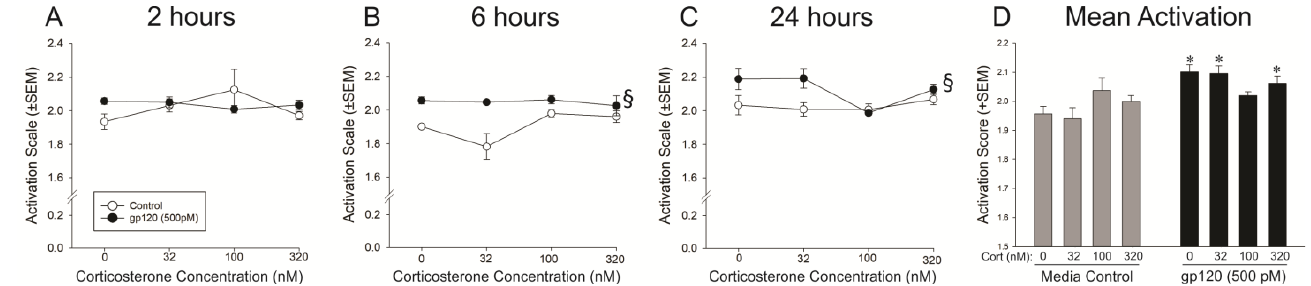
Figure 2. The average activation score of microglia at 2 h ( A ), 6 h ( B ) and 24 h post-treatment ( C ) and the mean activation score across all time-points ( D ). § time × gp120 interaction wherein gp120 significantly differs from media control at 6 and 24 h only; * gp120 × corticosterone interaction wherein gp120-exposure significantly increases activation of all microglia except those exposed to 100 nM corticosterone; p < 0.05.